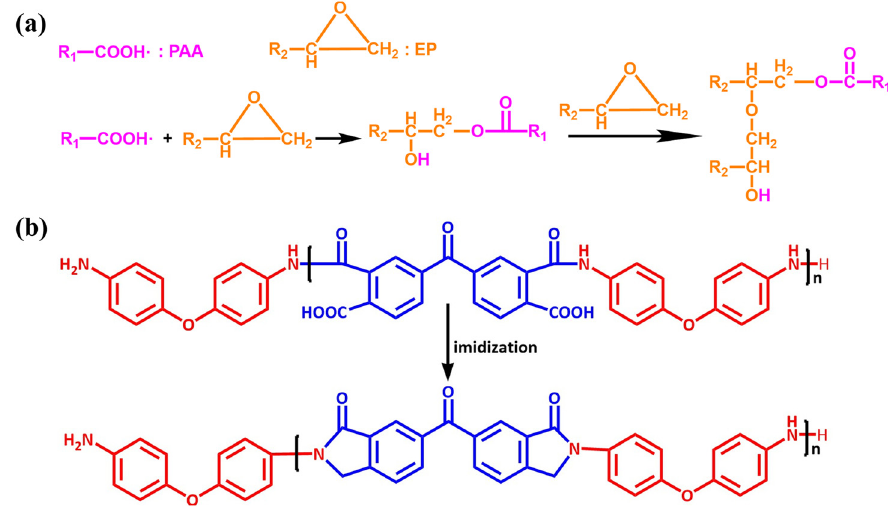
Figure 3: The reaction equation during thermal curing: ( a ) the reaction between PAA with EP and ( b ) the thermal imidization reaction of PAA.